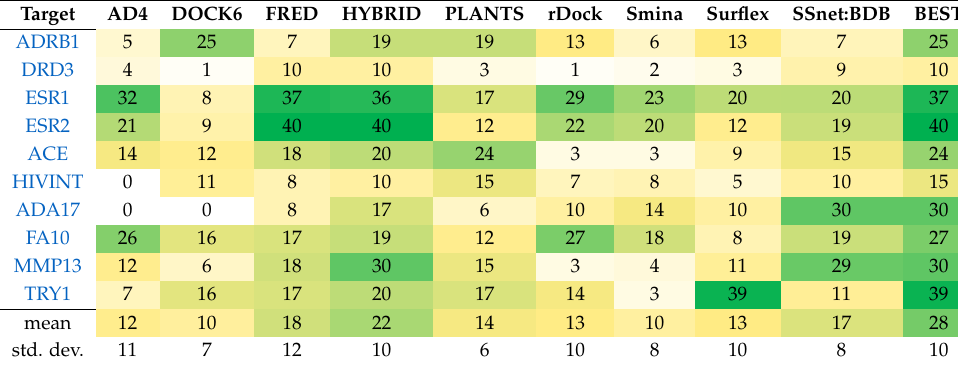
Table 5. EF 1% comparision on various models.